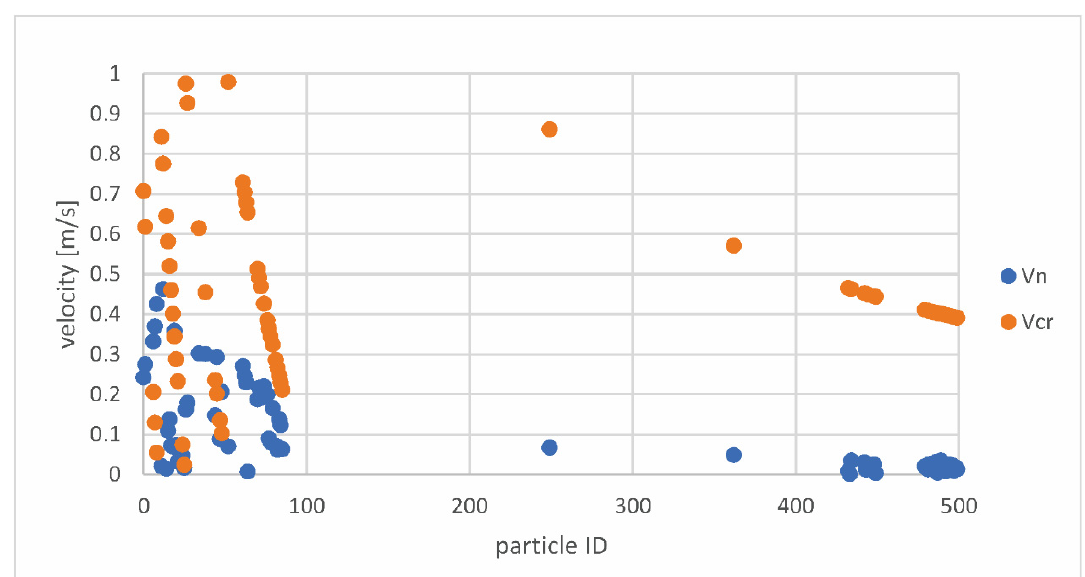
v v Figure 10. Relationship between the normal ( v n ) and critical ( v cr ) velocities for the same particle ID. Figure 10. Relationship between the normal ( n ) and critical ( cr ) velocities for the same particle ID. Based on Figure 10, which was created based on the Stick.txt file, it can be seen that the particles written in this file will stick to the surface/inhaler wall since, according to theory, a particle that has a normal impact velocity smaller than the critical velocity will deposit in contact with the surface. This is consistent with the findings of Dahneke et al. [33], who determined that when the normal impact velocity drops, the relevance of the sticking force increases, resulting in lower rebound velocities. This indicates that there is no additional bouncing of the particles below a threshold amount of normal impact velocity, and the particles attach to the wall surface. Figure 11 shows the dependence of the critical and normal particle velocities on the z coordinate.